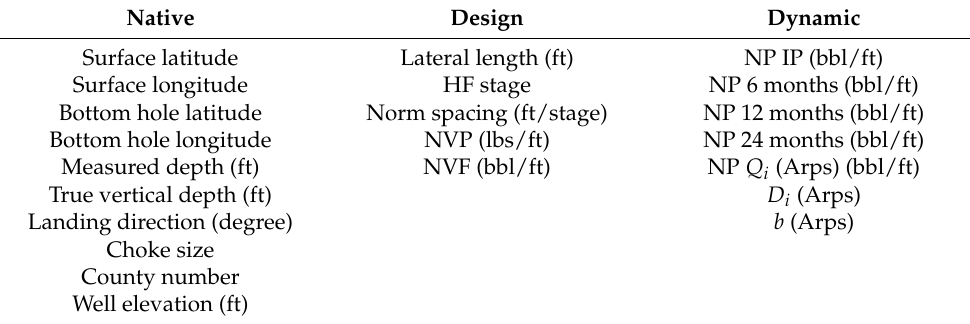
Table 4. List of input attributes in the case studies.